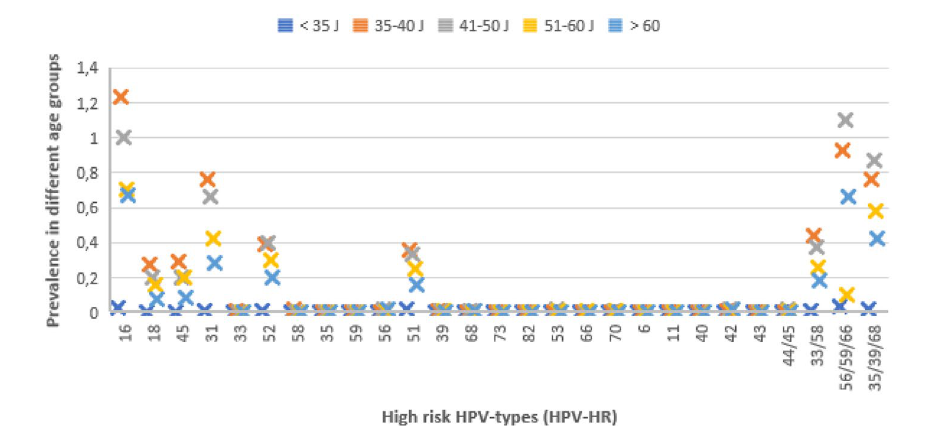
Figure 1. The prevalence of detecting HPV-high risk subtypes in different age groups.